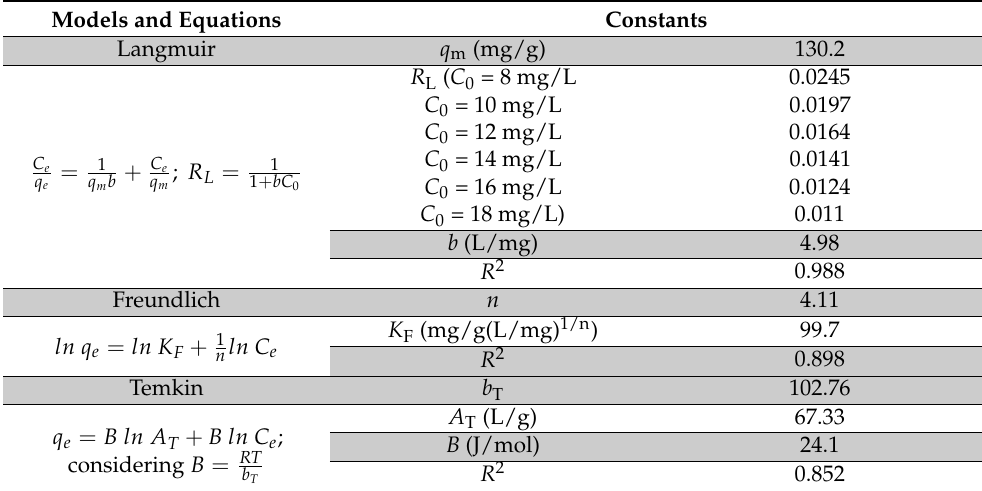
Table 2. Constant parameters and correlation coefficients calculated for different adsorption isotherm models at different temperatures for MB adsorption on